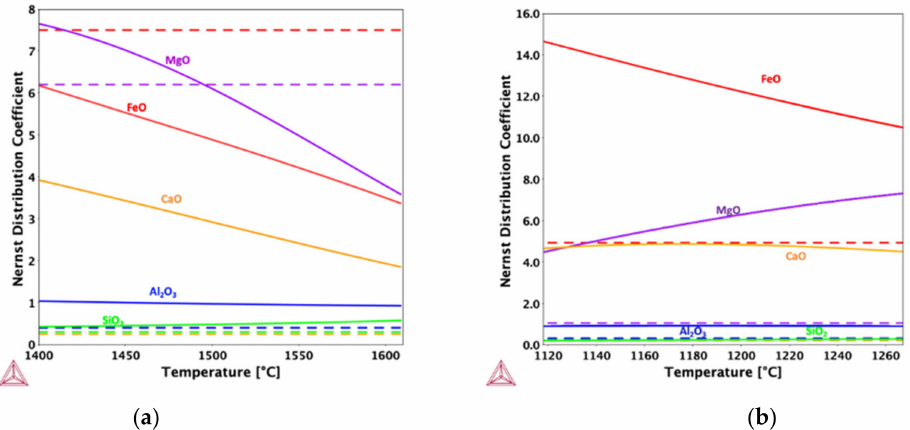
Figure 5. Predicted Nernst distribution coefficients between two liquids vs. those derived by analytical measurements for ( a ) L Fe -dispersed and ( b ) L Si -dispersed. Dashed curves correspond to analytical measurements and colors correspond to different components (FeO-red, SiO 2 -green, Al 2 O 3 -blue, CaO-orange,